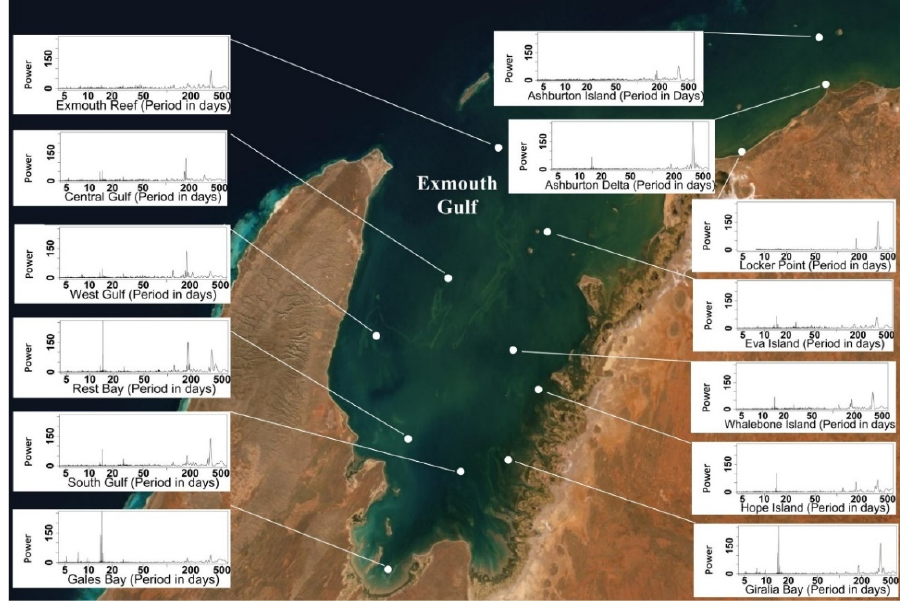
Figure 6. Lomb–Scargle periodograms with x-axis showing TSM spectral frequencies (period in days) at 13 locations in the Exmouth Gulf; y-axis denotes Lomb–Scargle Power.